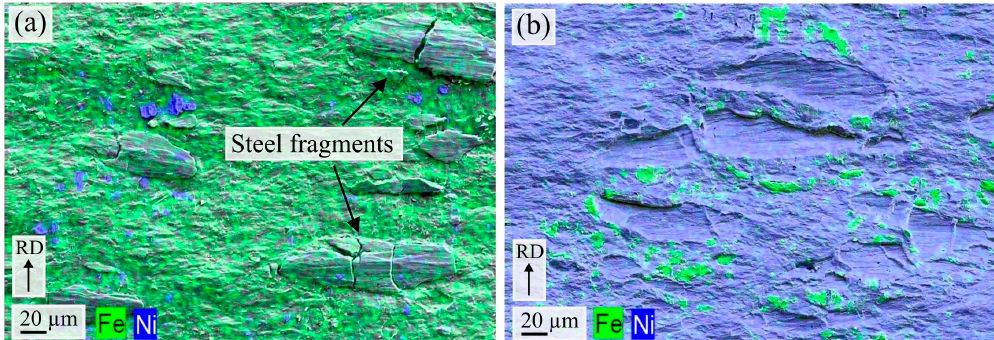
Figure 3. SEM images overlaid with corresponding energy dispersive X-ray spectroscopy (EDS) color maps of the steel and nickel fracture surfaces after peel-testing of a rolled composite. Detected nickel is colored blue and iron is colored green. ( a ) shows the steel fracture surface where steel fragments and small areas with residual nickel can be observed. ( b ) shows the nickel fracture surface, with small areas of residual iron. RD indicates the rolling direction.